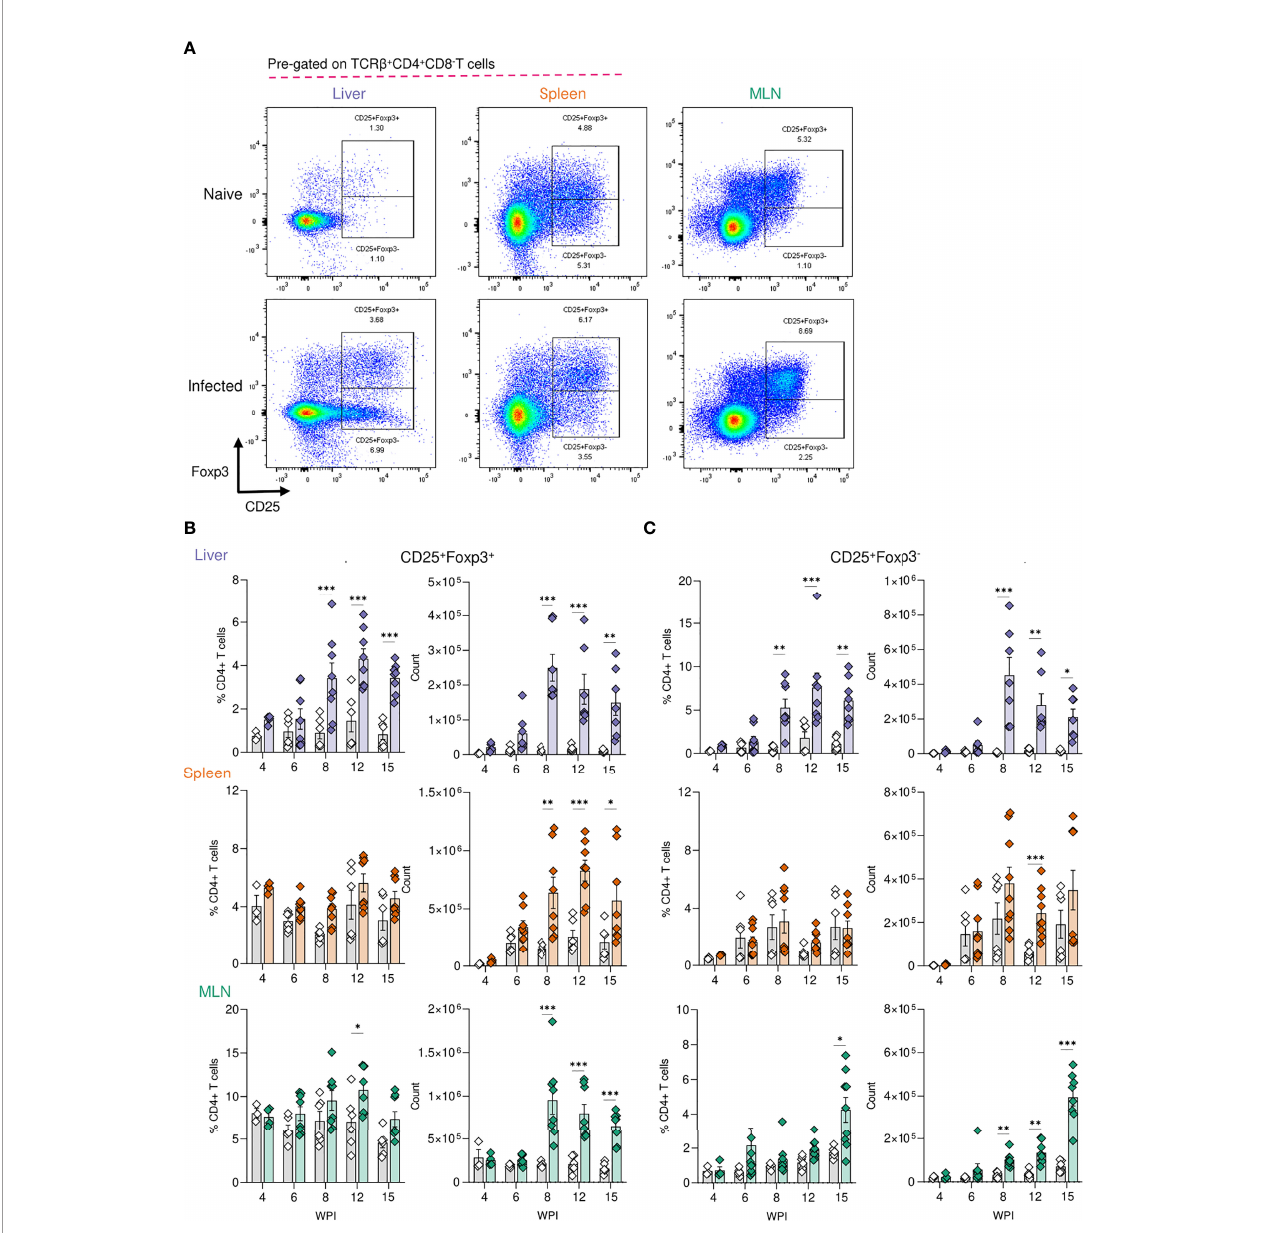
FIGURE 3 | Regulatory T cell dynamics across S. mansoni infected tissues. (A) Representative fl ow plots for CD25 + Foxp3 + and CD25 + Foxp3 - gating, pre-gating on live CD45 + TCR b + CD4 + CD8 - cells. The frequency and total numbers of (B) CD25 + Foxp3 + T cells and (C) CD25 + Foxp3 - cells in the liver, spleen and MLN of naïve and 40 cercariae infected mice, at indicated timepoints, and with frequency presented as % of total CD4+ T cells. (B, C) . Results are mean +/- SEM from two experiments pooled (wks 6-15) or a single experiment (wk4) (n=3-8 mice per group per time-point). Signi fi cance calculated by two-way ANOVA. *p < 0.05, **p < 0.01, ***p <